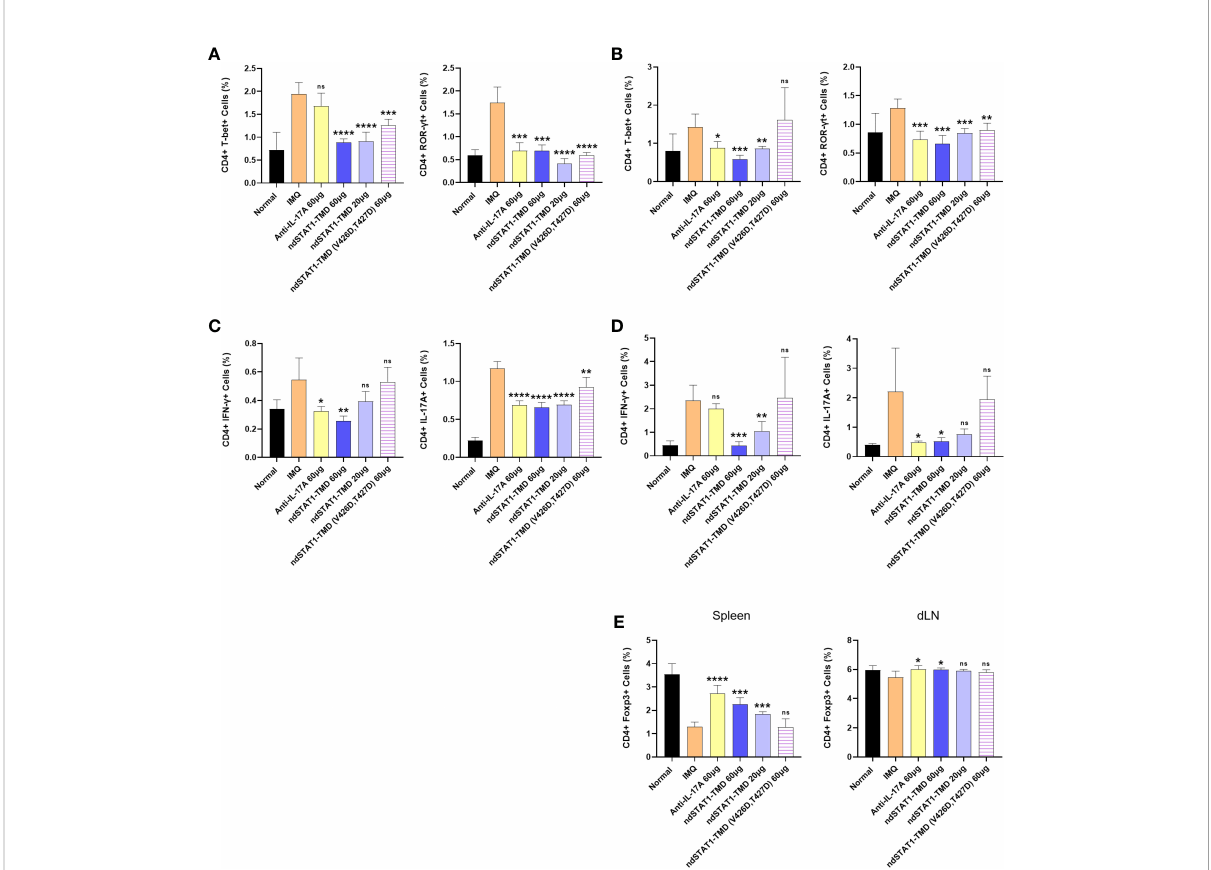
FIGURE 5 ndSTAT1-TMD treatment restores the disrupted functional status of CD4 + T cells in the psoriasis animal model. (A, B) The level of CD4 + T-bet + T cells (left panel of (A, B) ) or CD4 + ROR- g t + T cells (right panel of (A, B) ) in the spleen (A) and draining lymph nodes (dLN) (B) of each treated group was examined on day 7 by fl ow cytometry. (C, D) The level of CD4 + IFN- g + (left panel of (C, D) ) or CD4 + IL-17A + (right panel of (C, D) ) in the spleen (C) and draining lymph nodes (dLN) (D) of each treated group was analyzed on day 7. (E) The level of CD4 + Foxp3 + regulatory T cells in the spleen (left panel) or draining lymph nodes (dLN) (right panel) of each treated group. The graphs are represented as mean ± SEM (n=5), and the statistical analysis was examined using Student ’ s t-test. ns, not signi fi cant, *p<0.05, **p<0.01, ***p<0.001, and